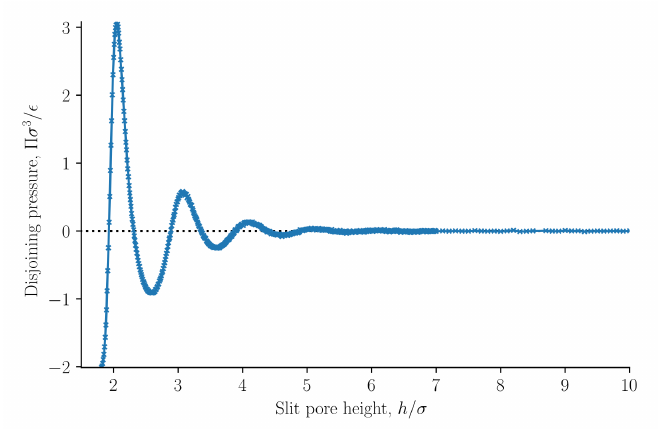
Figure 9. Disjoining pressure as a function the slit pore height h , see Equation (25).